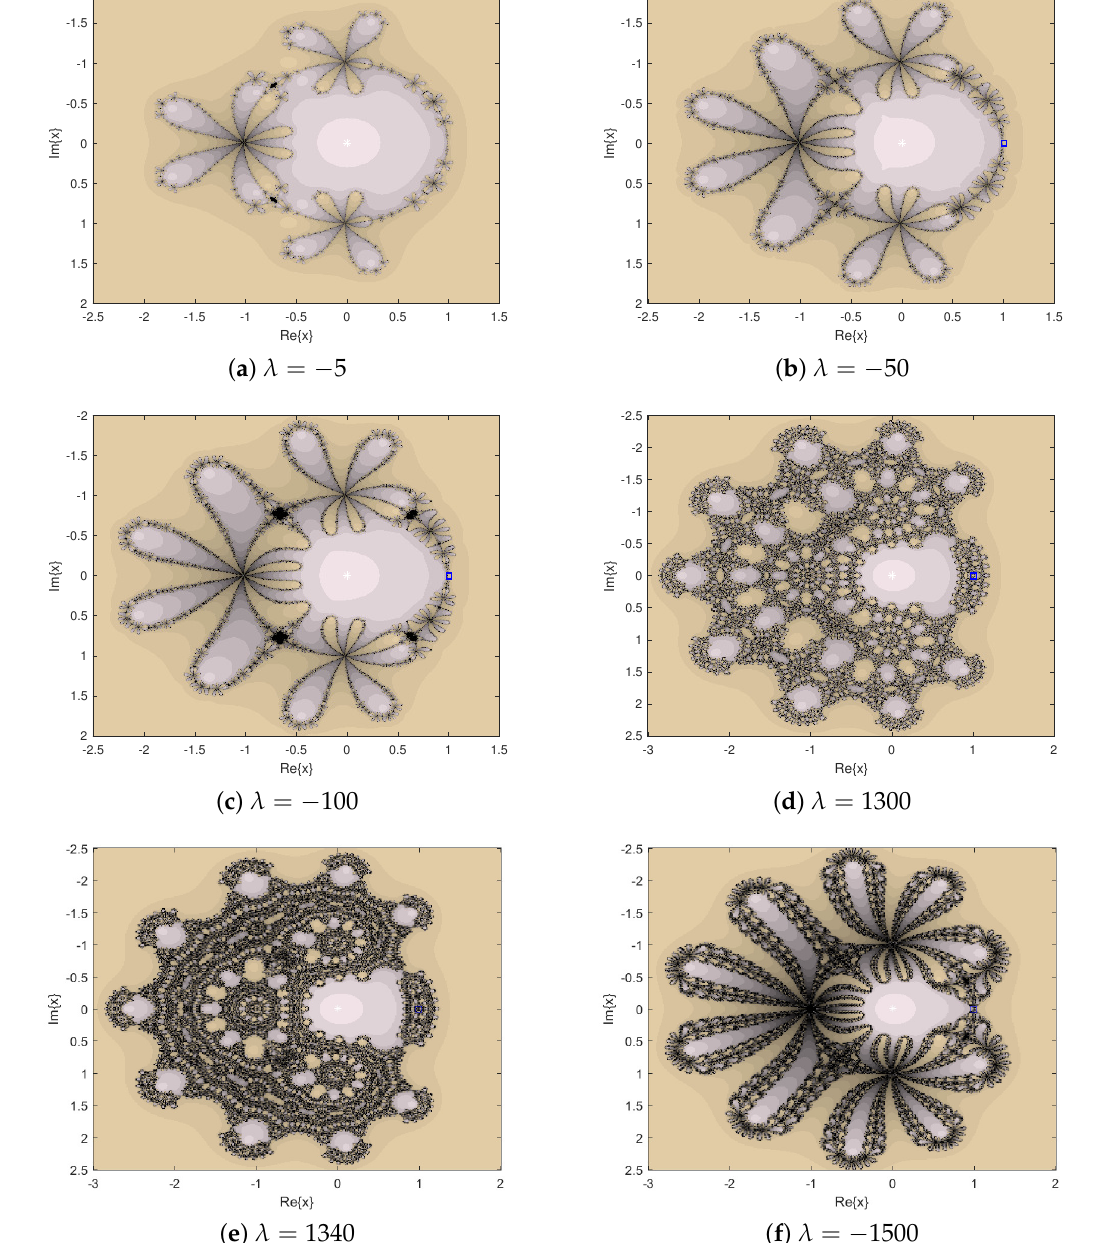
Figure 5. Dynamical planes for special λ